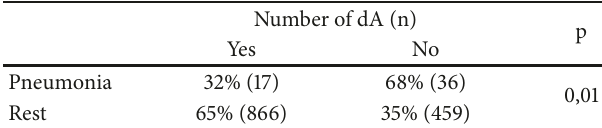
Table 6: dA for “cardiac decompensation” compared to the remain- ing diagnoses